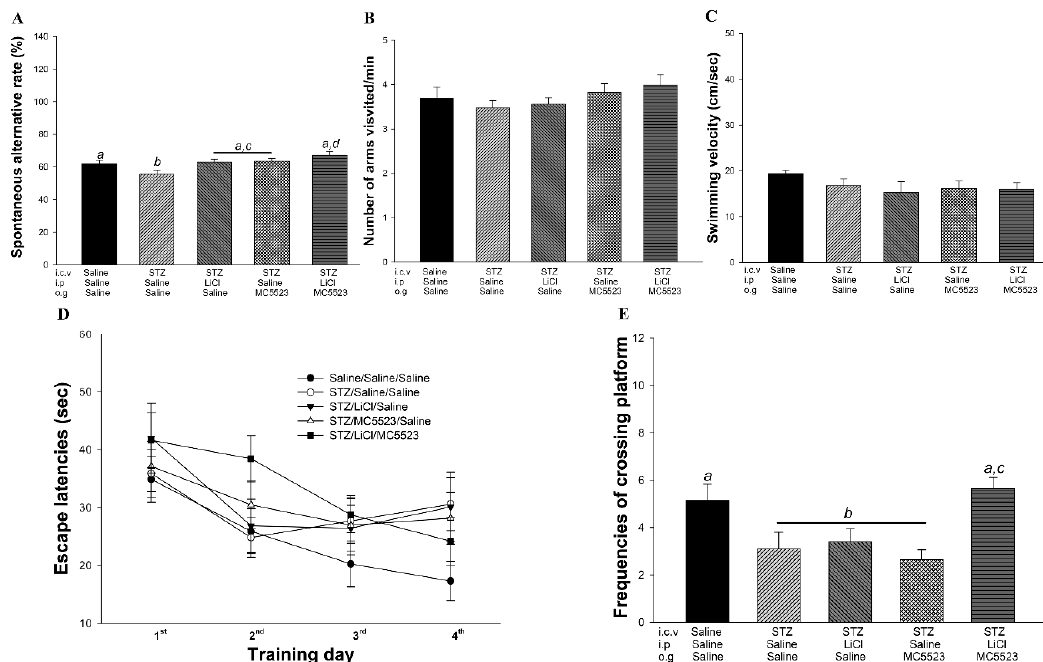
Figure 4. MC5523 greatly improved short-term memory and spatial cognition in LiCl-treated icv-STZ B6 mice. ( A ) Spontaneous alternation rate in icv-STZ B6 mice treated with MC5523 and LiCl. Short-term memory retrieval in the groups treated with LiCl and MC5523 was better than that in the groups treated with LiCl or MC5523 alone. ( B ) The number of arms visited by icv-STZ mice treated with LiCl and/or MC5523. There were no specific preferences for any arms among the mice. ( C ) Swimming velocity of the mice in the Morris water maze (MWM). The mice in all groups showed the same swimming ability. ( D ) Learning trends of the mice over the 4 MWM training days. The escape latencies were decreased in both the STZ/Li/MC5523 and saline/saline/saline groups from training days 1 to 4. ( E ) Long-term memory retrieval results. A probe trial was conducted 48 h after the final training trial to evaluate long-term memory retrieval. Long-term memory retrieval impairment was observed in